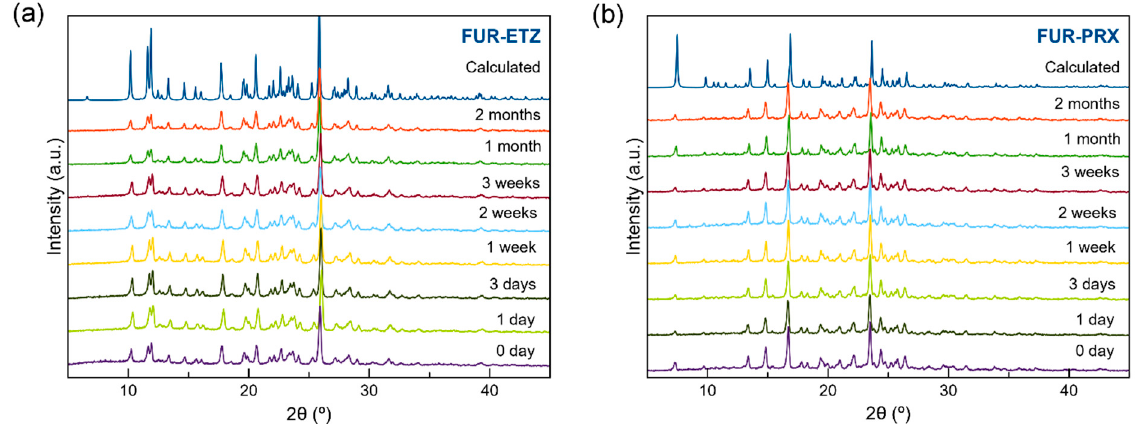
Figure 7. PXRD patterns of FUR–ETZ ( a ) and FUR–PRX ( b ) with respect to the stability under accelerated ageing conditions (40 °C, 75% RH) at different time intervals.